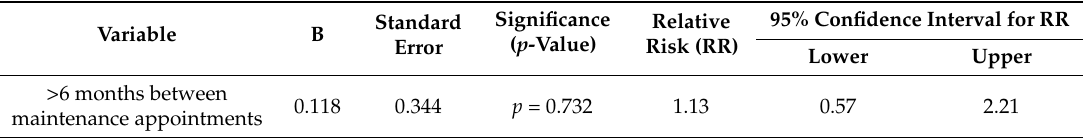
Table 4. Conditional logistic regression model for the association between the average time interval between maintenance appointments and the incidence of peri-implant disease.